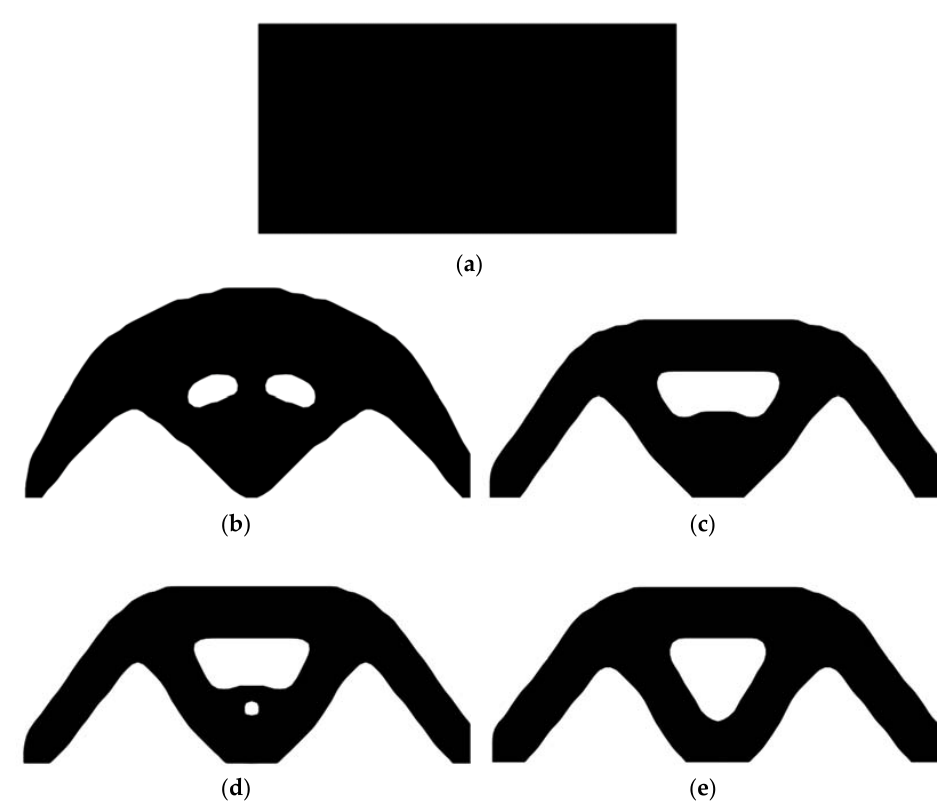
Figure 17. Optimal design problem of simple bridge beam by CBT level set topology optimization,